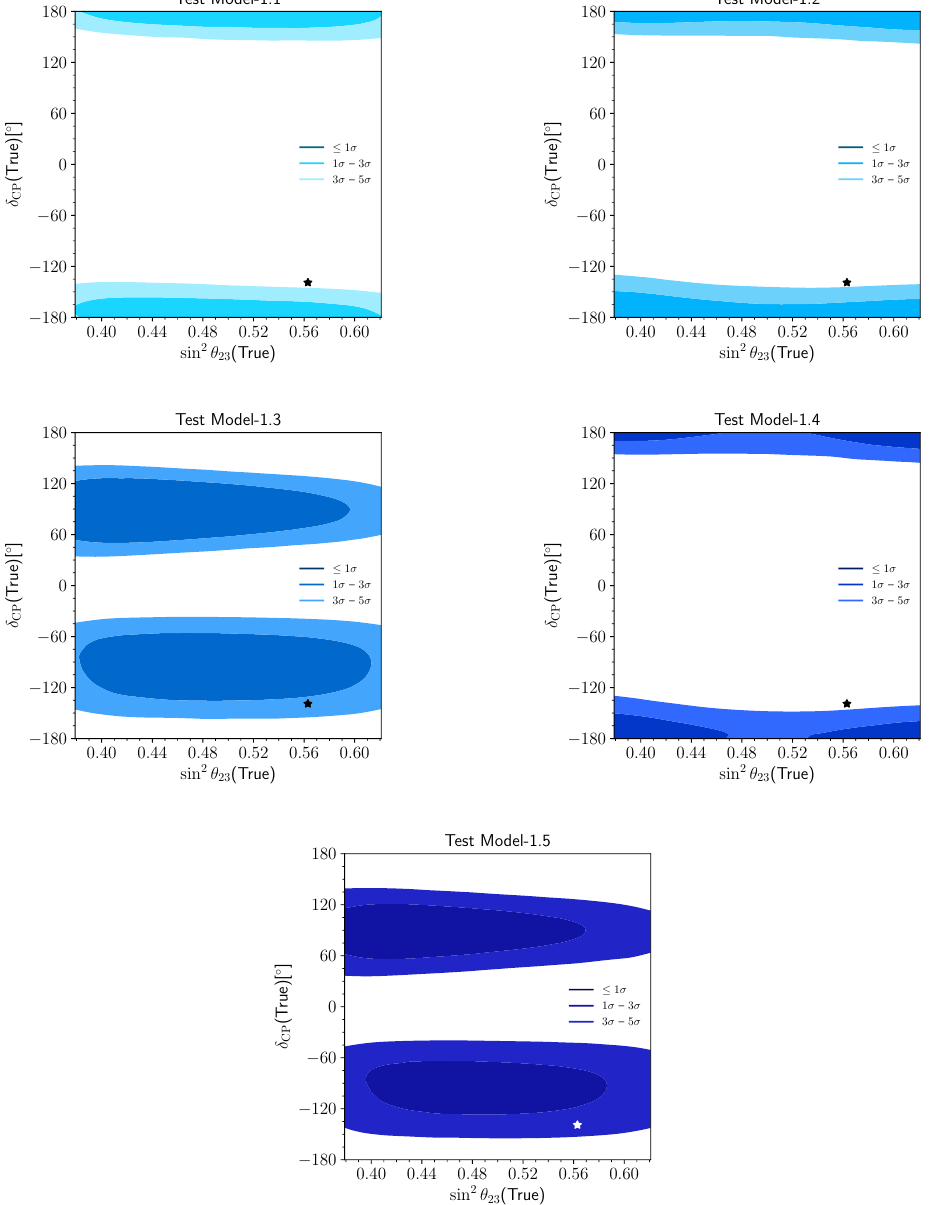
Figure 11 . Compatibility of the (cid:12)ve allowed one-parameter models with any potentially true values of sin 2 (cid:18) 23 and (cid:14) CP for ESSnuSB. For the other neutrino oscillation parameters, we assume the following true values sin 2 (cid:18) 12 = 0 : 310, sin 2 (cid:18) 13 = 0 : 02237, (cid:1) m 2 2 : 528 10 (cid:0) 3 eV 2 . A star (\ ? ") indicates the present best-(cid:12)t values of sin 2 (cid:18) 23 and (cid:14) CP from global (cid:1) neutrino oscillation data. The contours correspond to the indicated number of sigmas for 3 d.o.f.